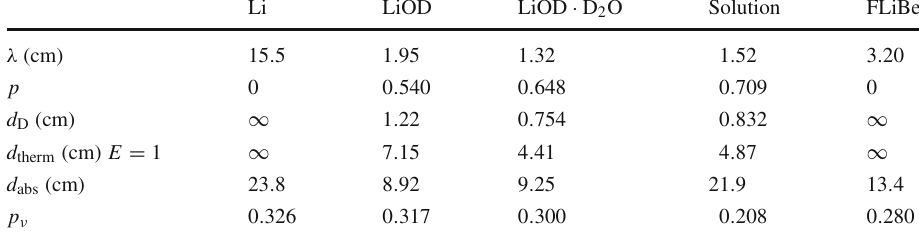
properties of each